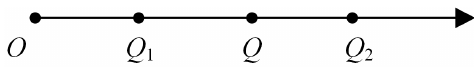
Figure 7. 2-D extension set of lateral stability.